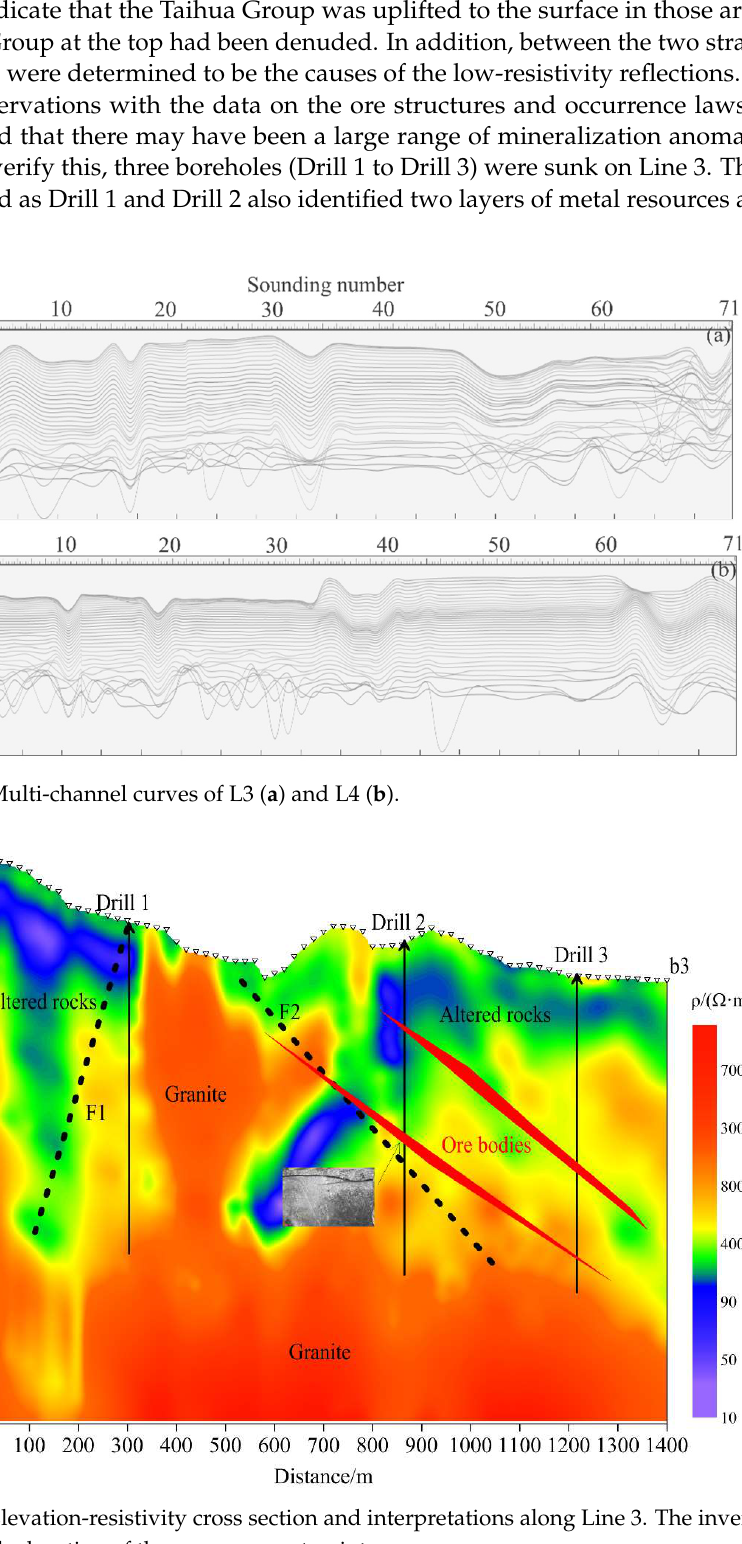
Figure 7. Elevation-resistivity cross section and interpretations along Line 3. The inverted triangles represent the location of the measurement points.